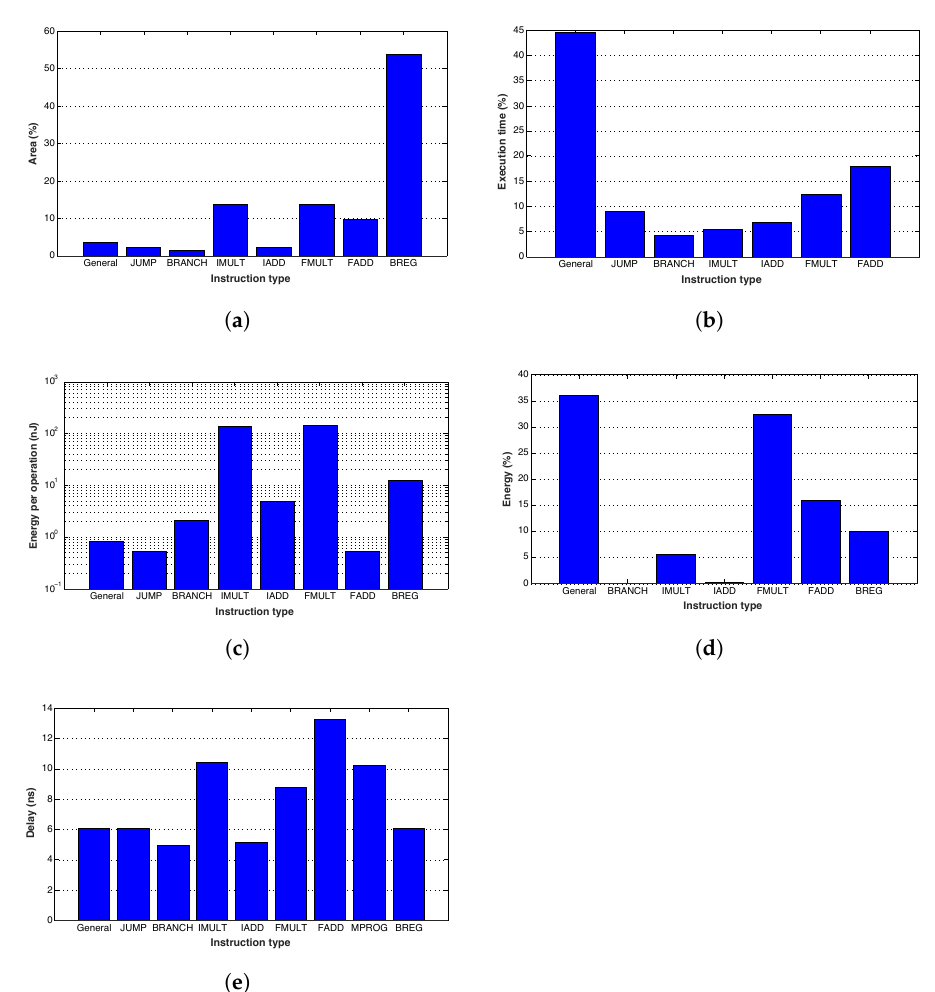
Figure 19. Estimated characteristics for the implementation of FFT algorithm with customized PAMPIUM microcontroller. ( a ) Area. ( b ) Execution time. ( c ) Dynamic energy per operation. ( d ) Total energy. ( e ) Critical